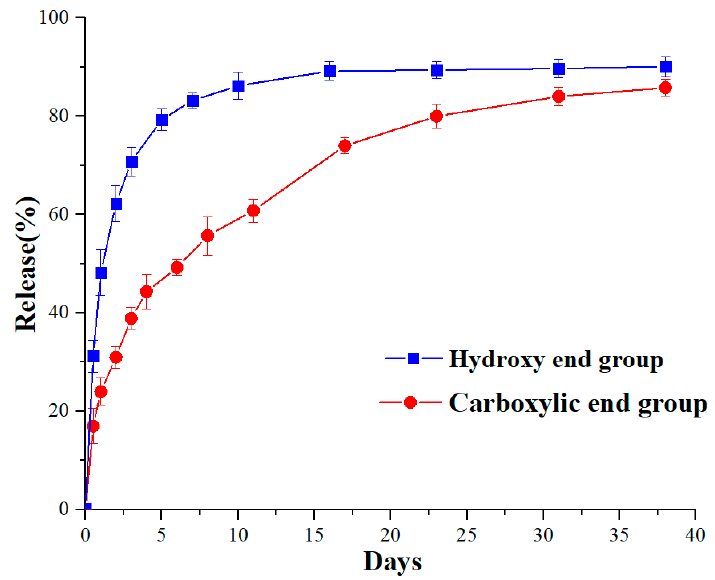
Figure 8. In vitro release profiles of Leuprorelin acetate from hydroxyl terminated PECP hydrogel and carboxylic terminated PECP hydrogel.